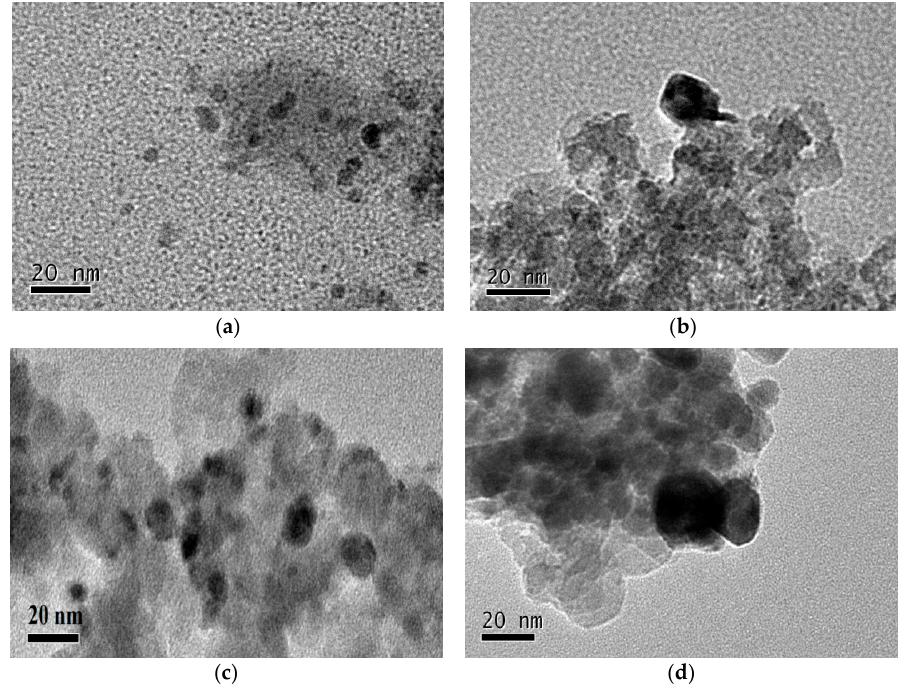
Figure 6. TEM images of the catalysts reduced at different temperatures: ( a ) 350 °C; ( b ) 400 °C; ( c ) 450 °C; ( d ) 500 °C.